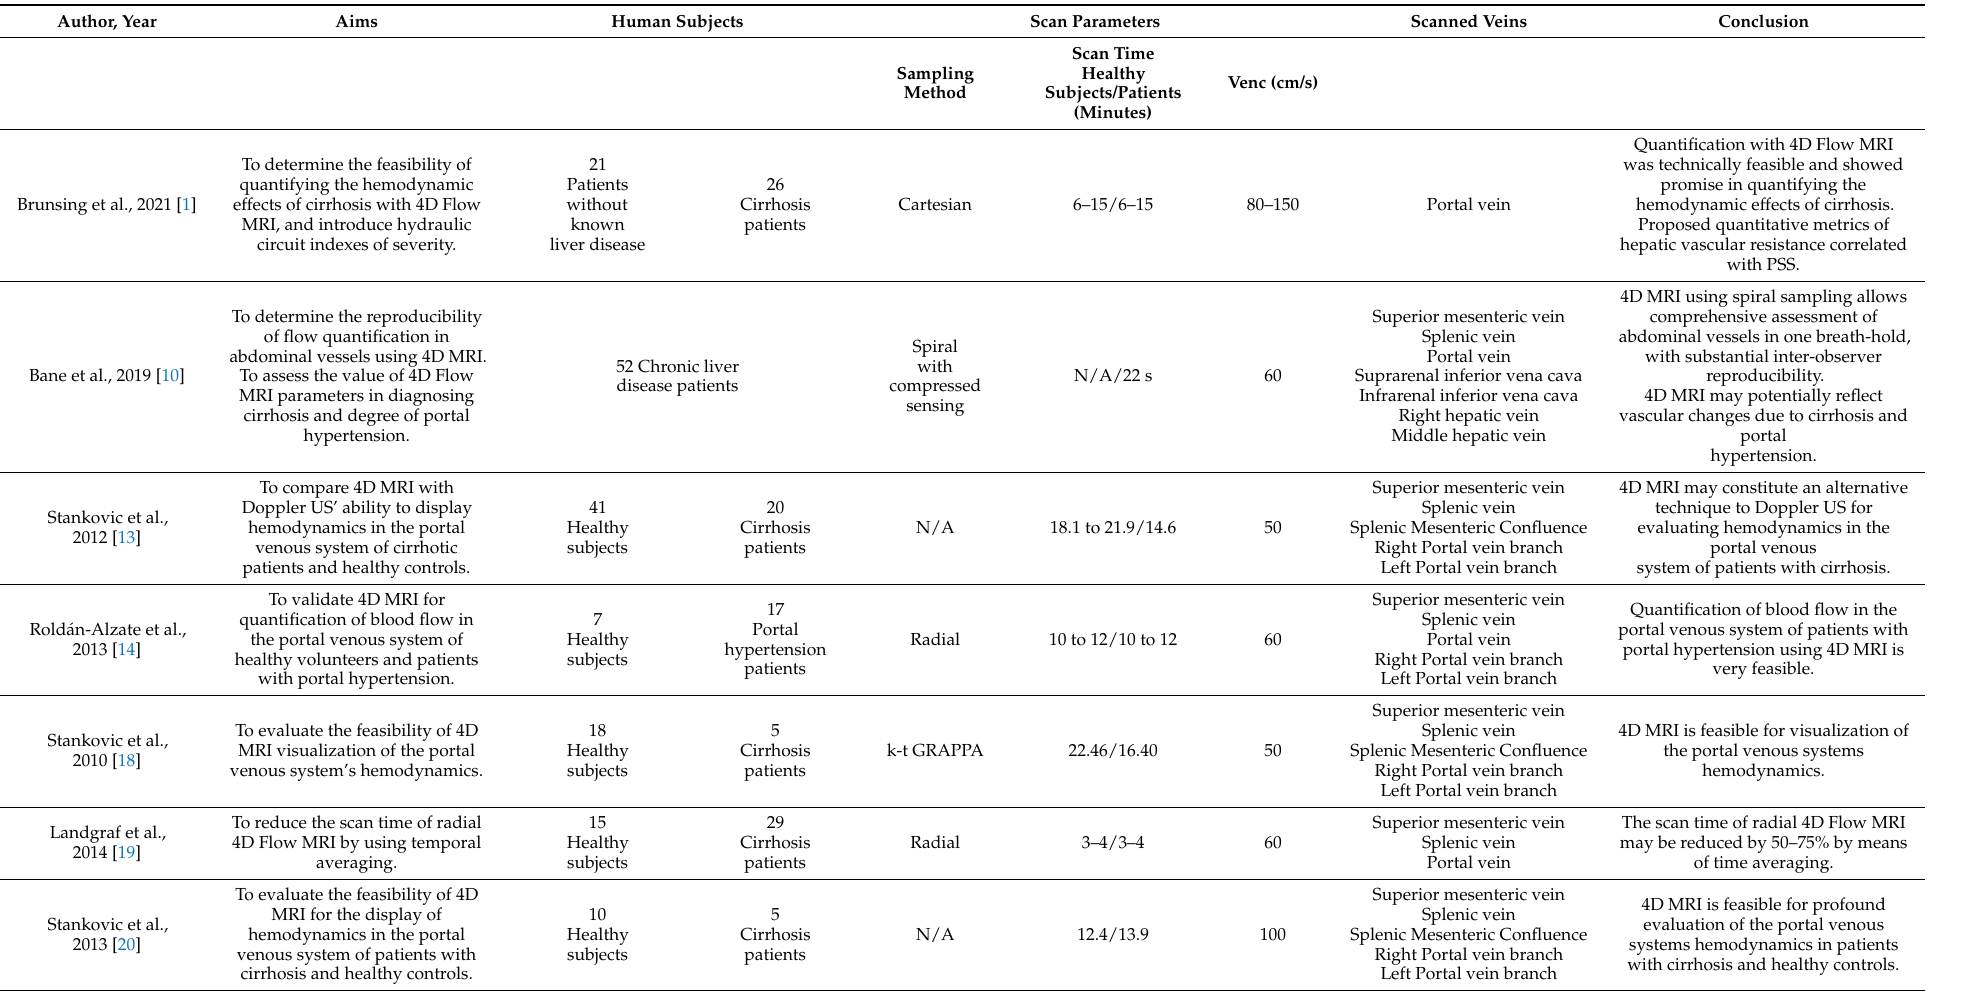
Table 1. Aims, subject types, scan parameters, scanned veins, and conclusions of included